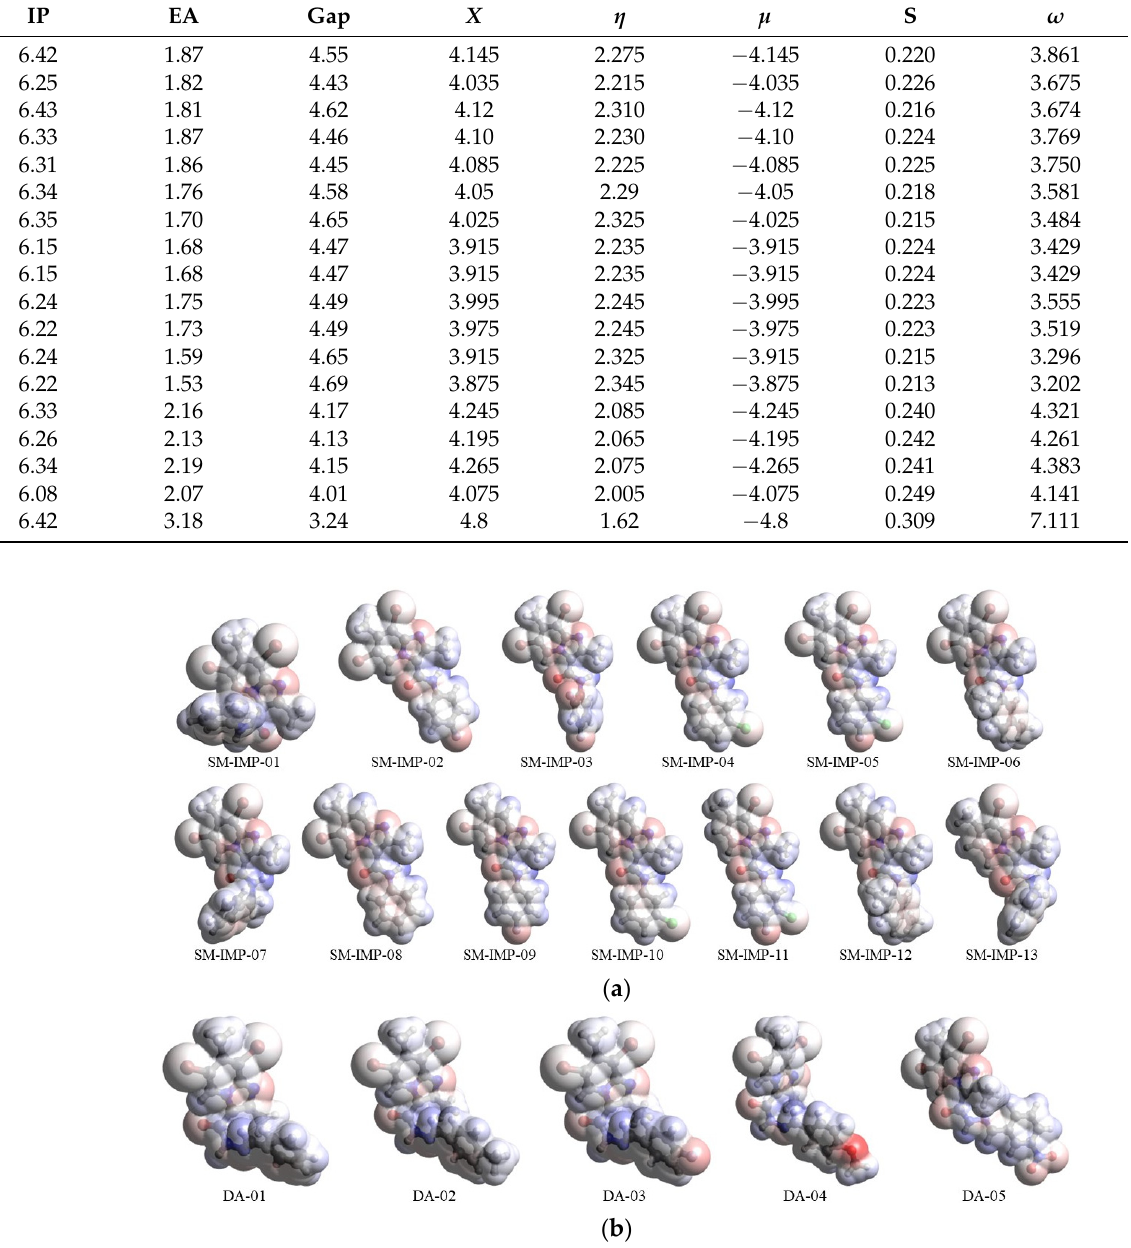
Table 2. GRPs for all the compound studies, eV, B3LYP/6-311+G(d,p), implicit water.